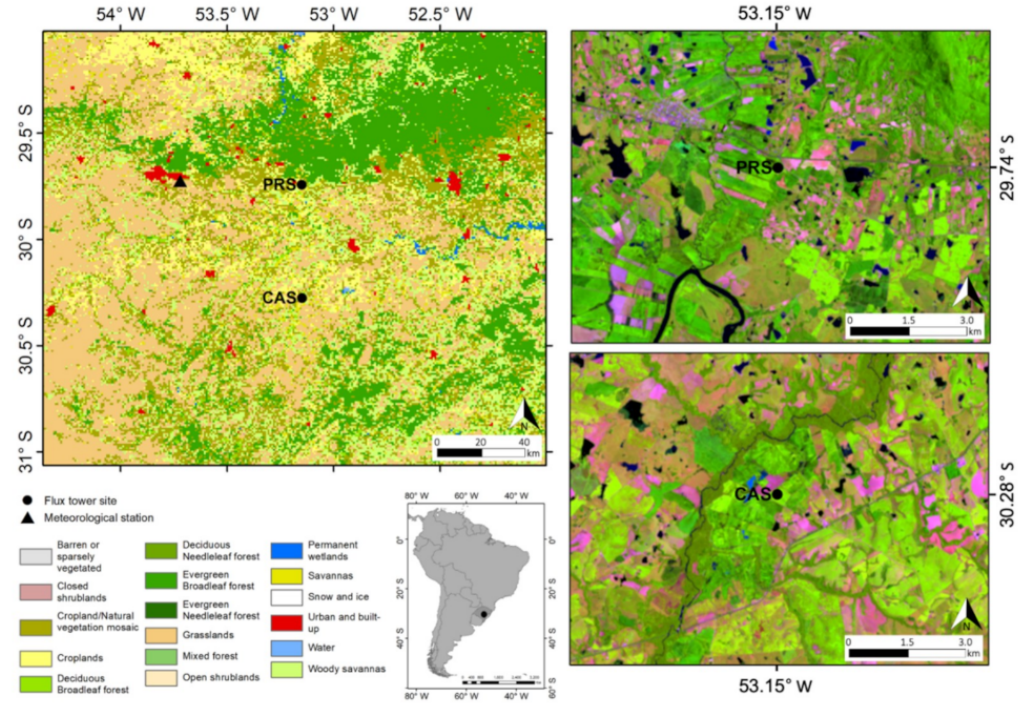
Figure 1. Land use and land cover from MODIS land cover type product (MCD12Q1) around the flux tower sites ( left ) and flooded rice crops highlighted in light green color located in Para í so do Sul (PRS) ( top right ) and Cachoeira do Sul (CAS) ( bottom right ). The false-color (R6G5B4) compositions are from LANDSAT 8 OLI (Land Remote Sensing Satellite / Operational Land Imager) sensor for 28 January